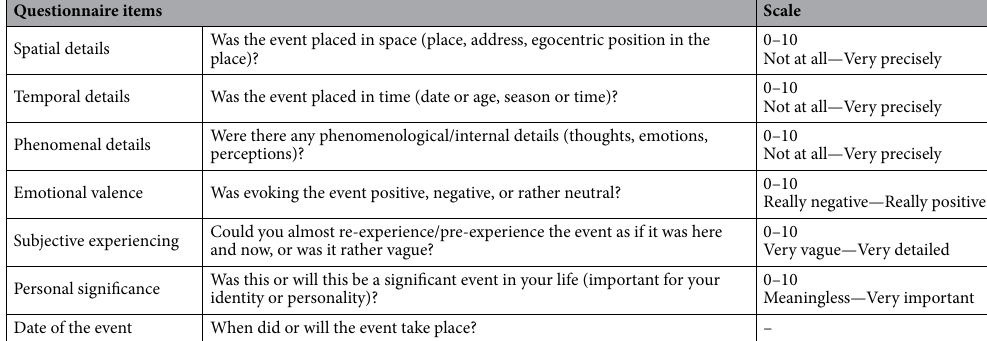
Questionnaire items